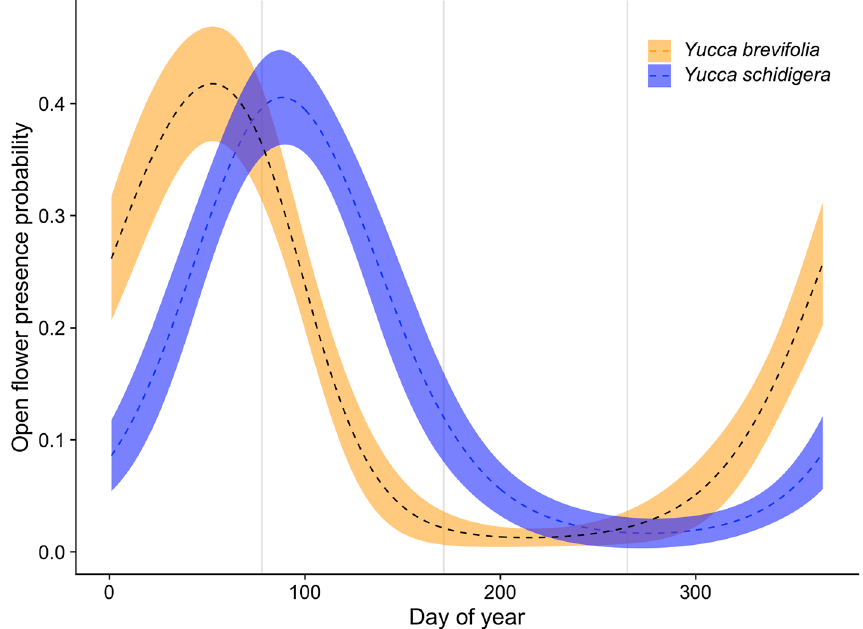
Figure 2. The probability of open flower presences given the day of year for the two species under normal bloom conditions.